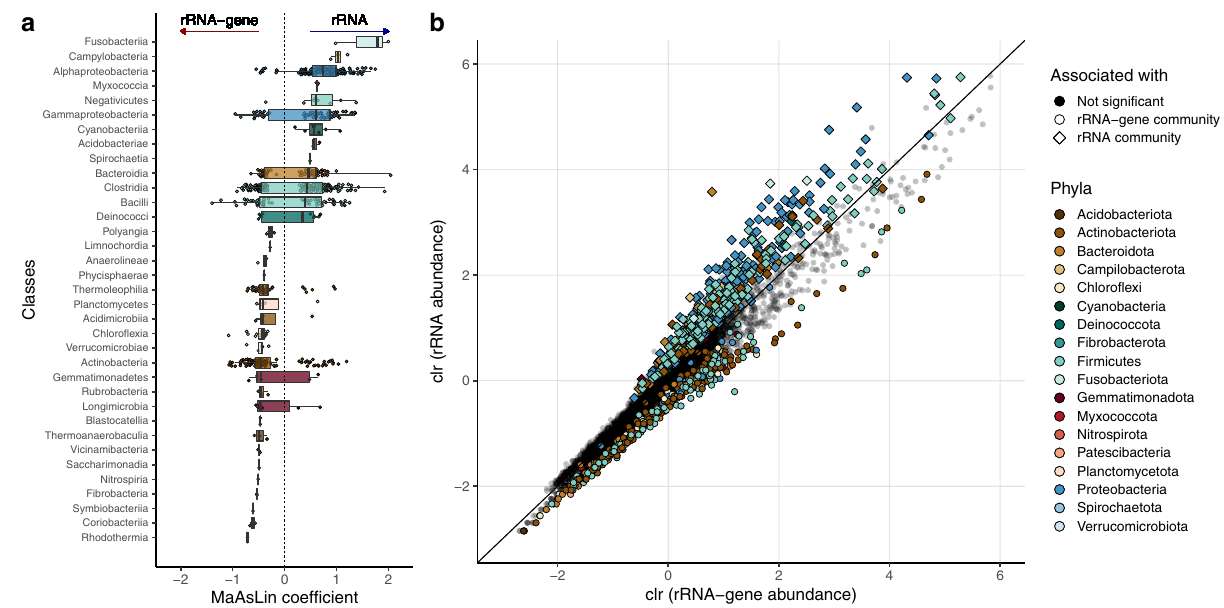
Fig. 6 Bacterial taxa signi fi cantly associated with rRNA vs. rRNA-gene communities. a The MaAslin2 scores per class are presented with association to rRNA and rRNA-gene communities. Each color represents a different phylum. Box plot center lines represent the median values, the lower and upper hinges correspond to the fi rst and third quartiles (the 25th and 75th percentiles), the lower and upper whisker extends from the hinge to the lowest and largest value no further than 1.5 * IQR from the hinge, and dots represent ASVs within each group. b ASV mean abundance (represented by clr-transformed counts) of rRNA (vertical axis) and rRNA-gene (horizontal axis). Each dot represents a different ASV. Signi fi cant results for ASVs with high rRNA abundance are depicted by colored diamonds, whereas ASVs with low rRNA abundance are shown as colored dots; each color represents a different phylum. The diagonal line represents the 1:1 ratio between rRNA to rRNA-gene